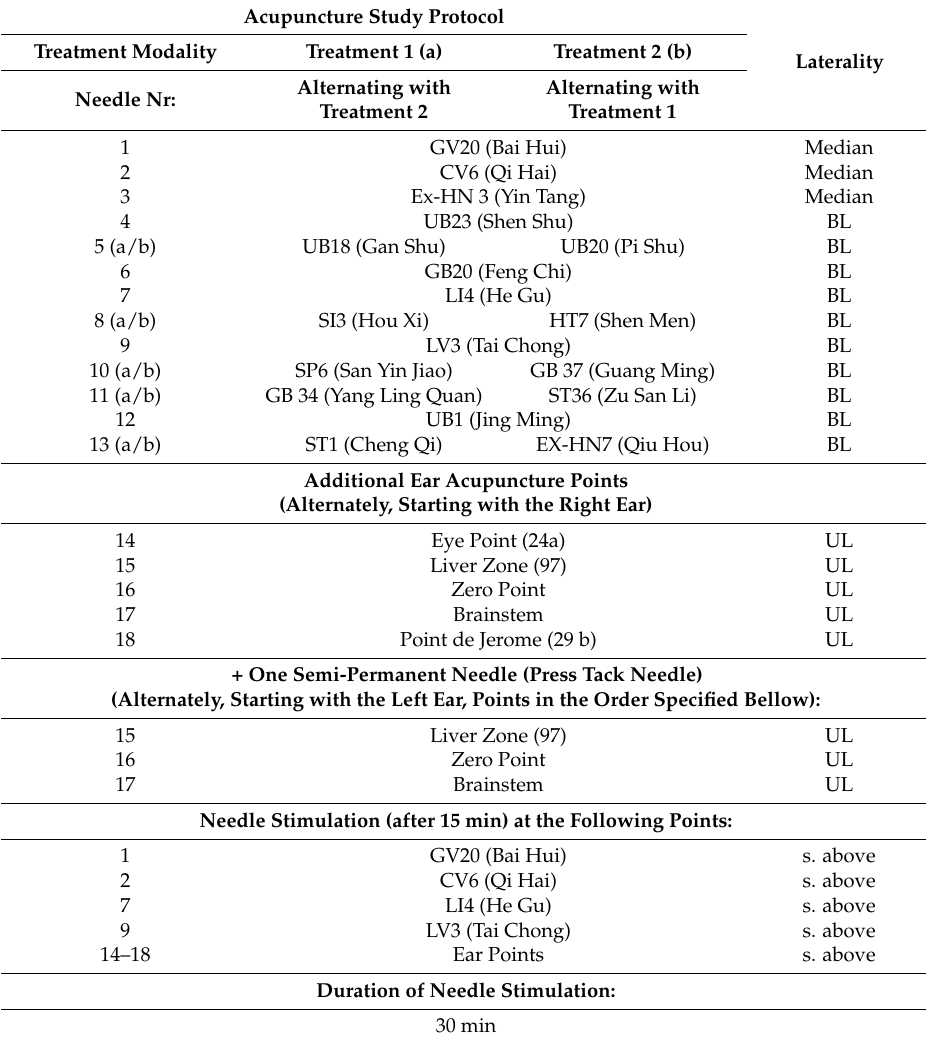
Table 1. All acupuncture points, the alternation in treatment (labeled in red, see also in Figure 1) and the stimulation duration. Standardized needles acupuncture protocol was applied as shown in Figure